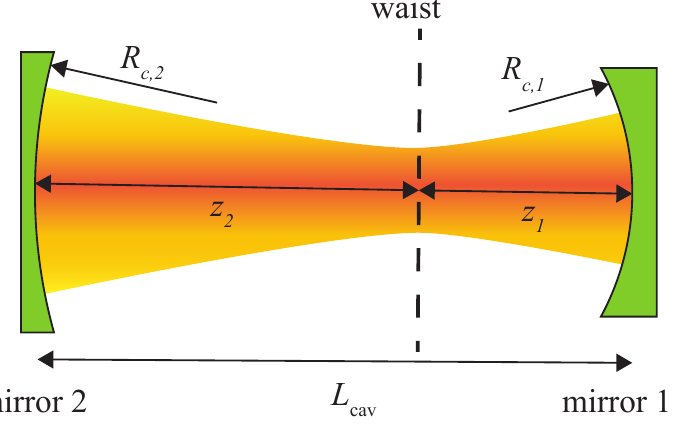
Figure 5. Schematic representation of a generalized two-mirror resonator, defining some of its parameters.